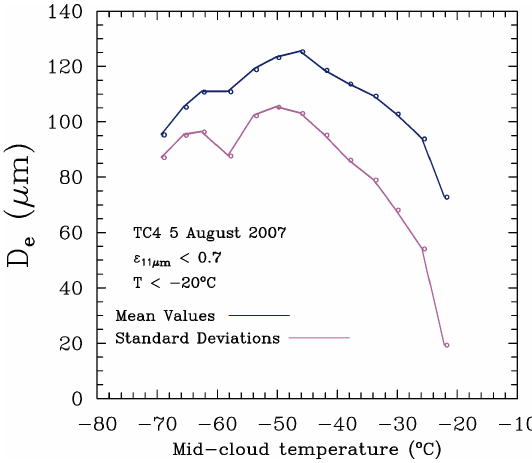
Fig. 14. Impact of the liquid fraction on the combined-phase effec- tive diameter D e corresponding to the means and standard devia- tions of β eff , for the 5 August 2007 case study. The liquid fraction near − 22 ◦ C is about